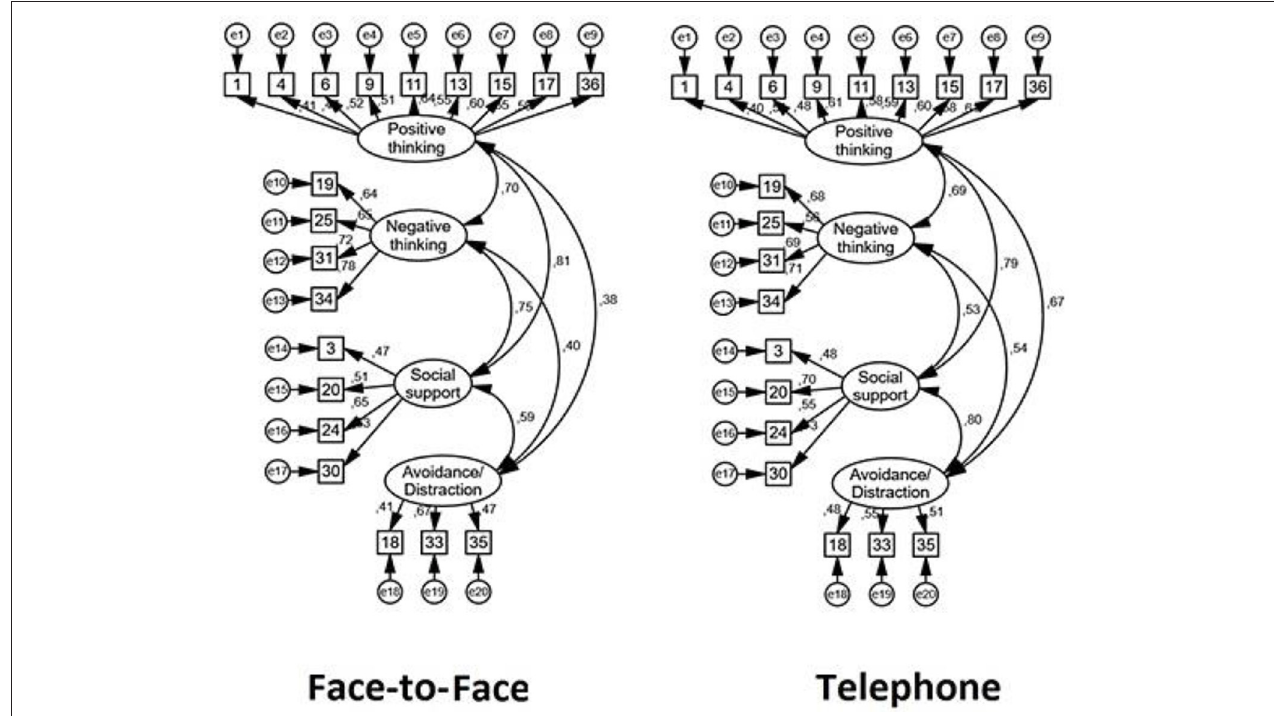
FIGURE 1 | Factor loading for each group (face-to-face and telephone counseling) after the CFA.